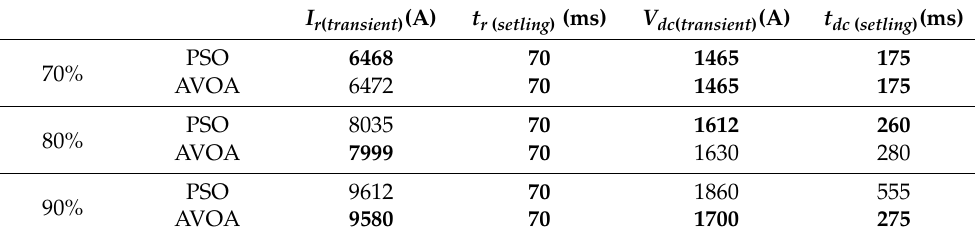
Table 1. Summary of results for optimization of crowbar resistance using swarm intelligence. I r ( transient )